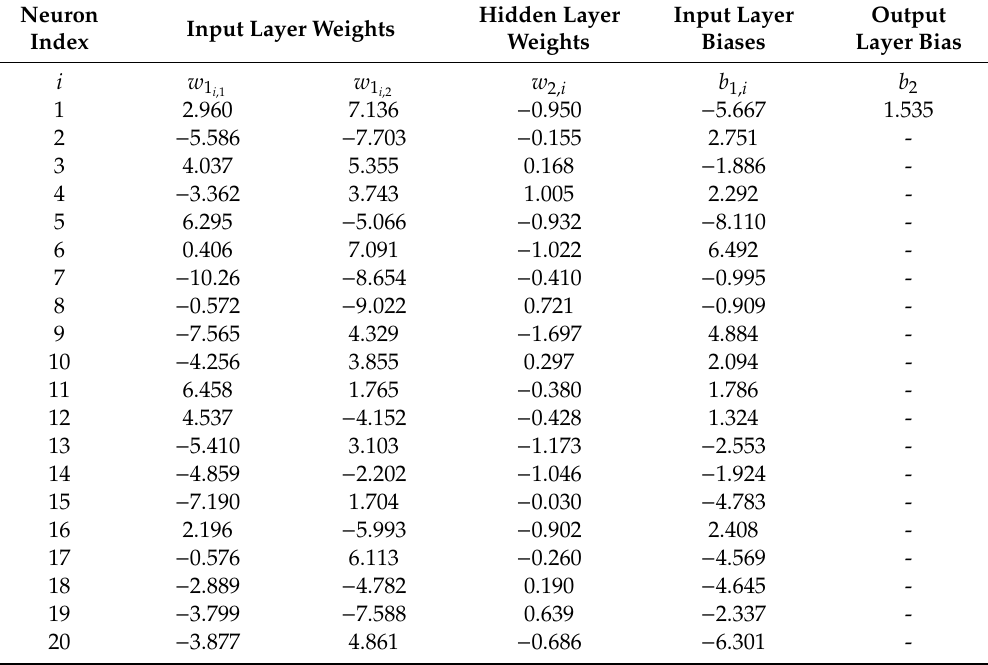
Table 5. The optimized coe ffi cients for estimating the normalized AV n in Equation (14).